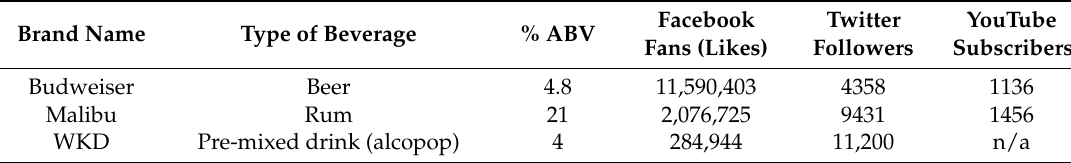
Table 3. Details of alcohol brands (as of 10 March